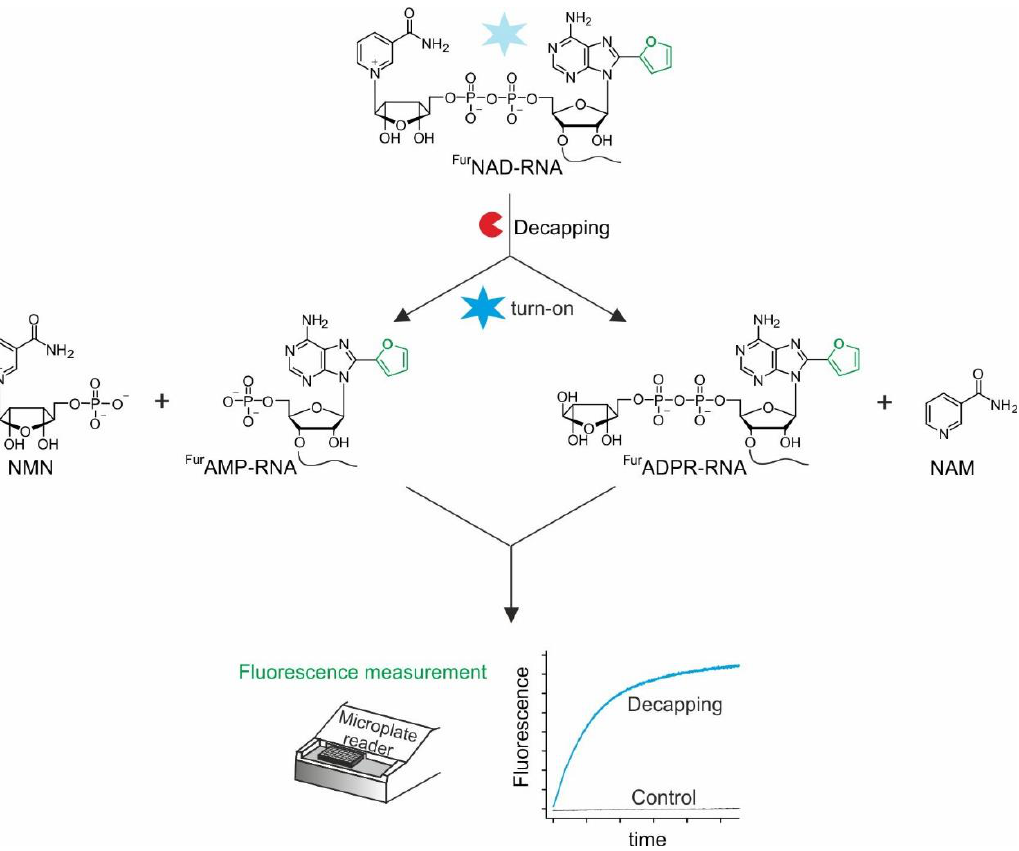
Figure 1. Fluorescence-based assay for NAD-RNA decapping using Fur NAD-RNA. The decapping enzyme can remove NMN or NAM.